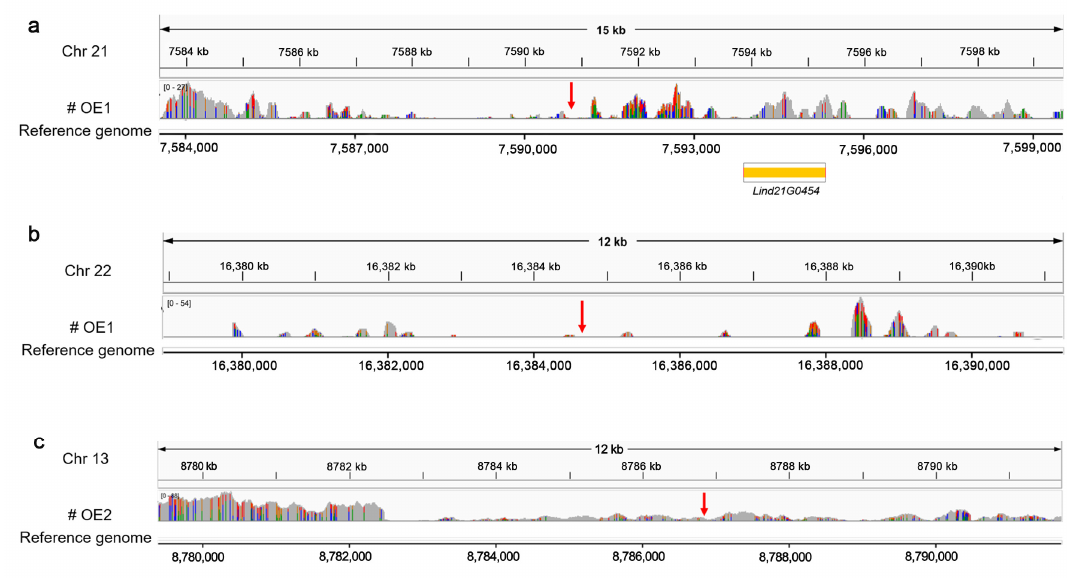
Figure 3. Next-generation sequencing provided the transfer DNA insertion site detection data. The red arrow indicates the T-DNA insertion site. The insertion of two T-DNA fragments was detected at the left boundary of chromosome 21 ( a ), and the right boundary of chromosome 22 in the overexpression OE1 ( b ), and the insertion of one T-DNA fragment was detected at the right boundary of chromosome 13 in the overexpression OE2 ( c